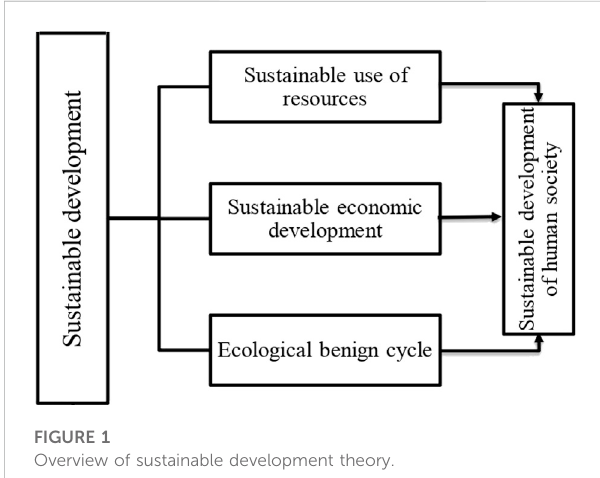
FIGURE 1 Overview of sustainable development